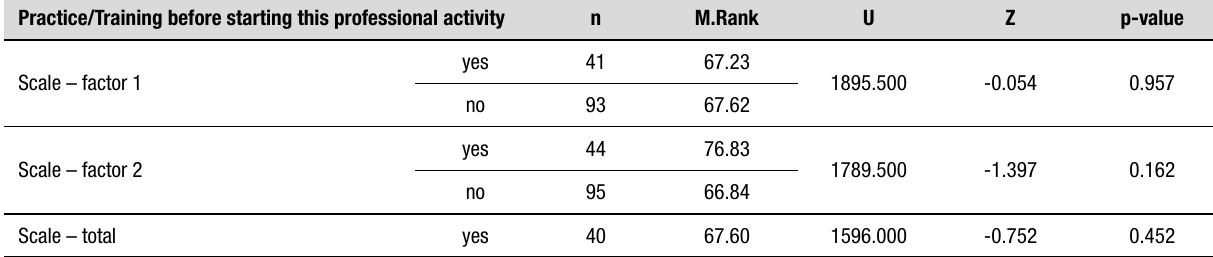
Table 4. Results of Mann-Whitney’s U test regarding the frequency of caregivers’ training before and after the professional activity and practices. Lisbon, Portugal. Practice/Training before starting this professional activity